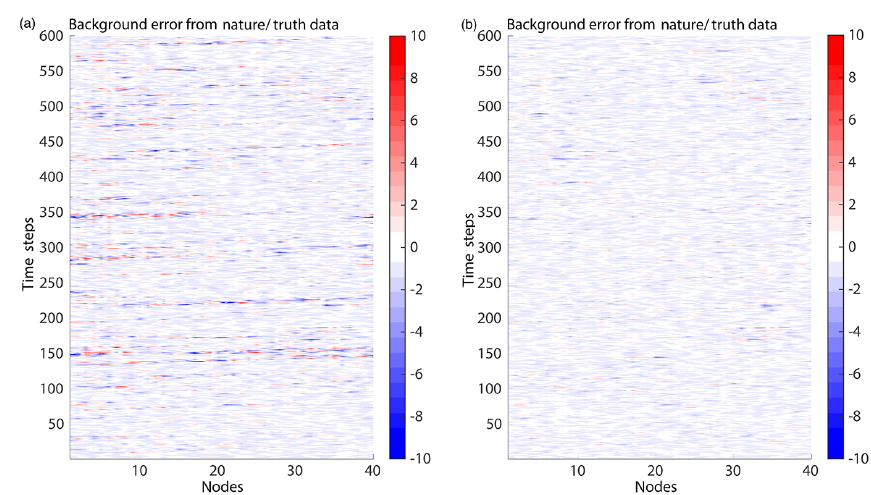
Figure 4. Forecast error for (a) LETKF and (b) LPF, using an analysis cycle window length d t = 0.5 (60h), localization radius r = 2 grid points, k = 100 ensemble members, and l = 80 observations sampled randomly on the domain (observation locations and errors are identical for both methods).